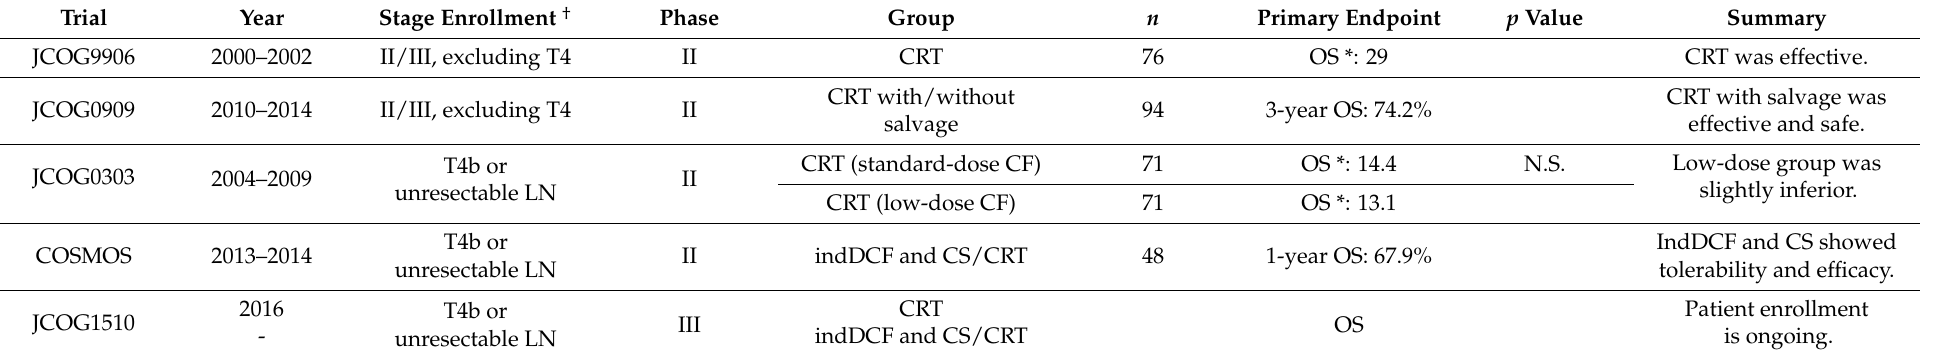
Table 3. Summary of clinical trials of CRT or induction chemotherapy for ESCC conducted in